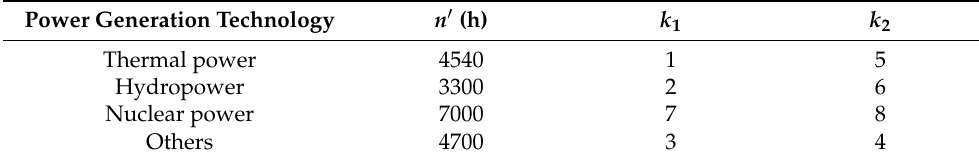
Table A2. Boundary value between the two peak shaving states and cost coefficients.